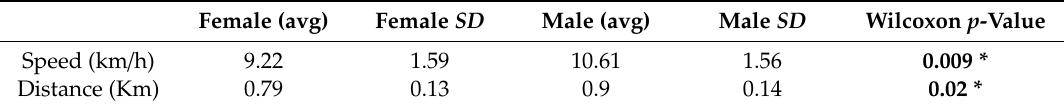
Table 2. Statistics and significance between sex and the speed and distance variables